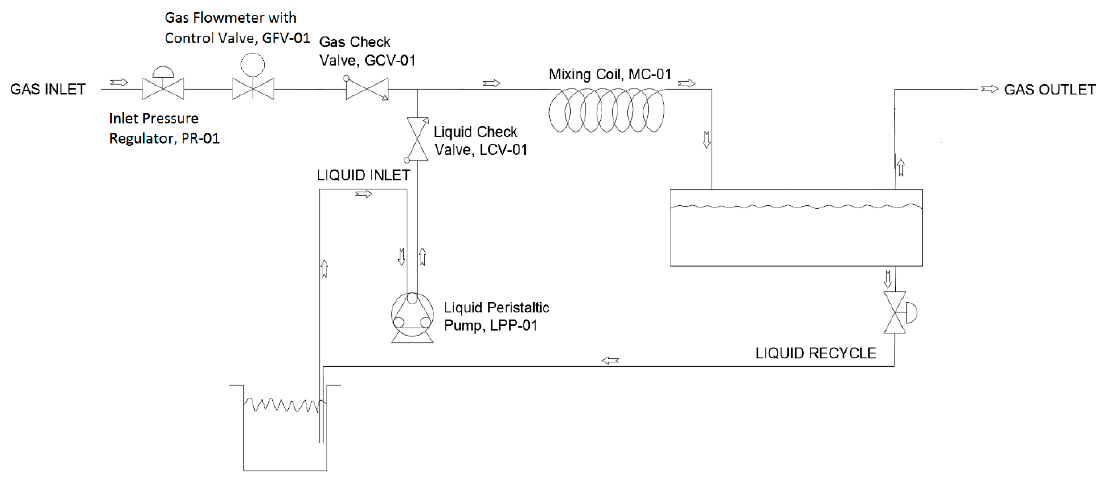
Figure 2. A schematic diagram of test rig.